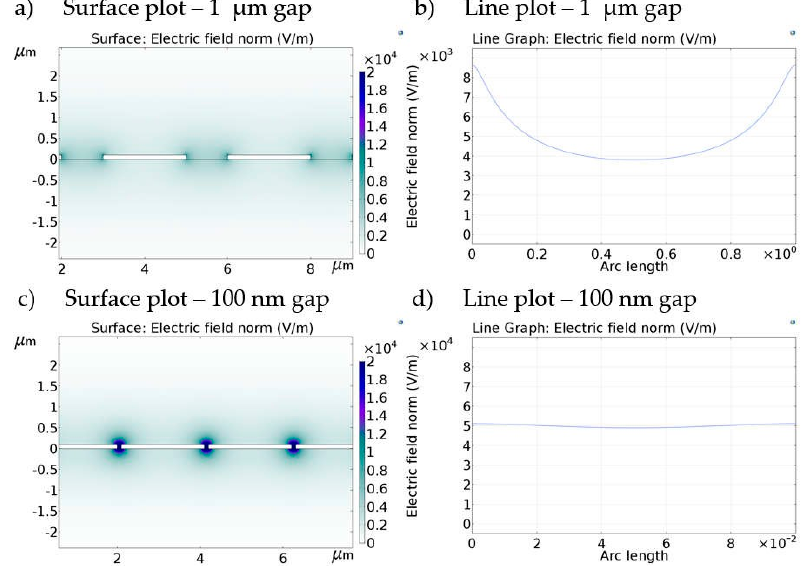
Figure 2. Simulation of the electric field strength in the vicinity of the electrodes for ( a ) gaps in the micrometer range and ( c ) nanogap interdigitated electrodes. 1D plot along a cut line crossing the electrode gap for ( b ) micrometer sized electrodes and for ( d )